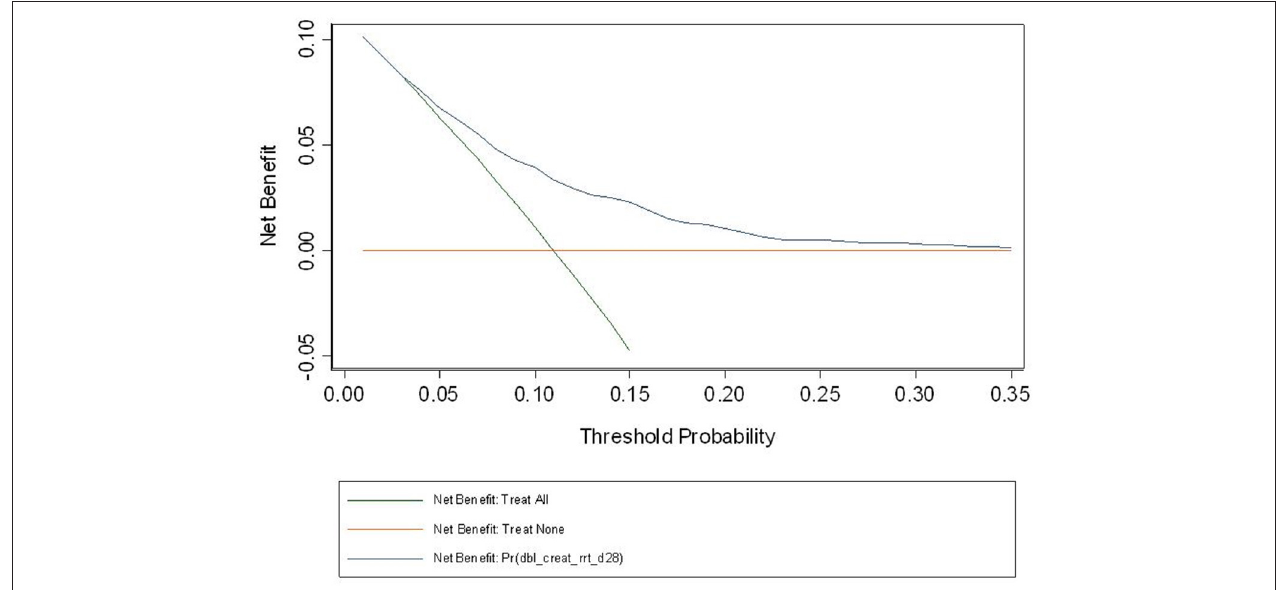
FIGURE 4 | Decision curve based on the final model. Decision curve analysis is a relatively recent approach, seeking to overcome the limitation of the usual model assessment tools such as calibration and discrimination in their clinical application. If one doesn’t use the model, then any intervention could be applied to everyone (intervention for all) or no-one (intervention for none). Between these two interventions sits the impact of the model, and the fact that our curve sits above the intersection of both curves, across the range of probabilities for AKI in our study population, suggest that the model will be of net benefit in this population. At a population level, the net benefit of the intervention treatment will be realized across a larger number of patients across the spectrum of